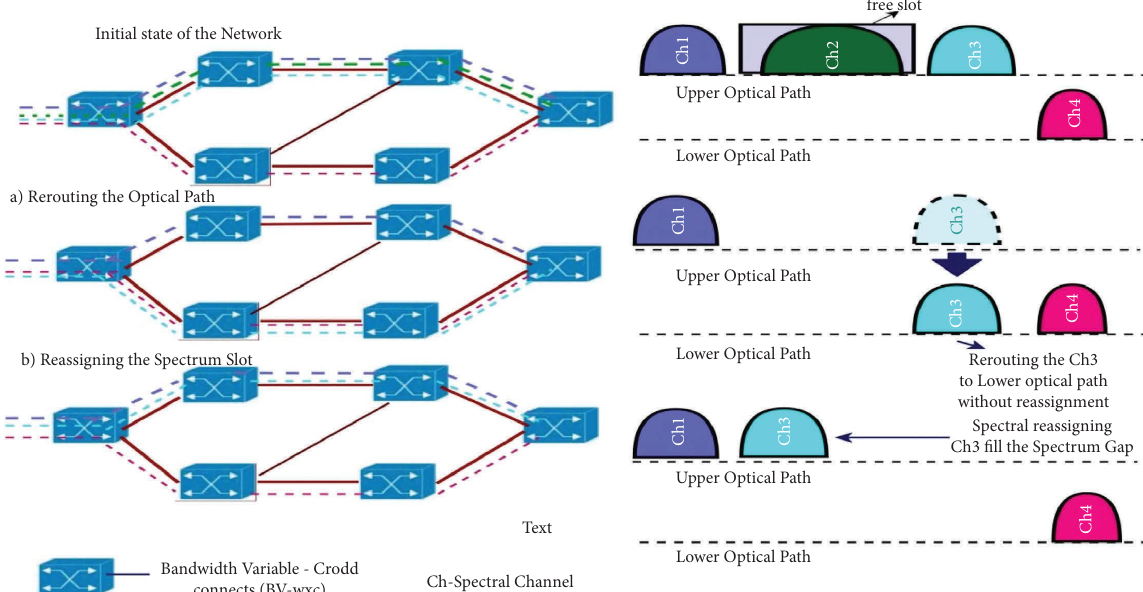
Figure 3: Fragmentation options (a) without reassigning the spectral channel and (b) reassigning the spectrum channel fll the spectrum gap when the other connection is released (ex. Ch2).